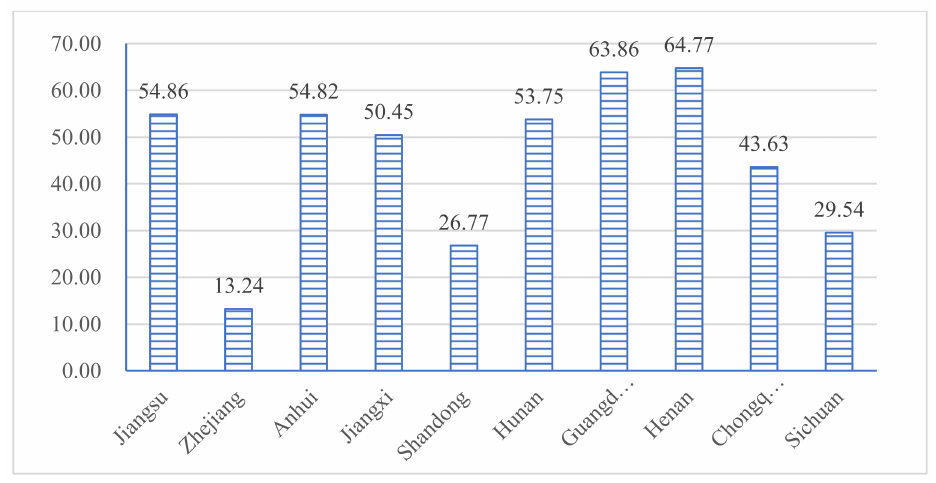
Figure 5. Scores of governance capacity for each